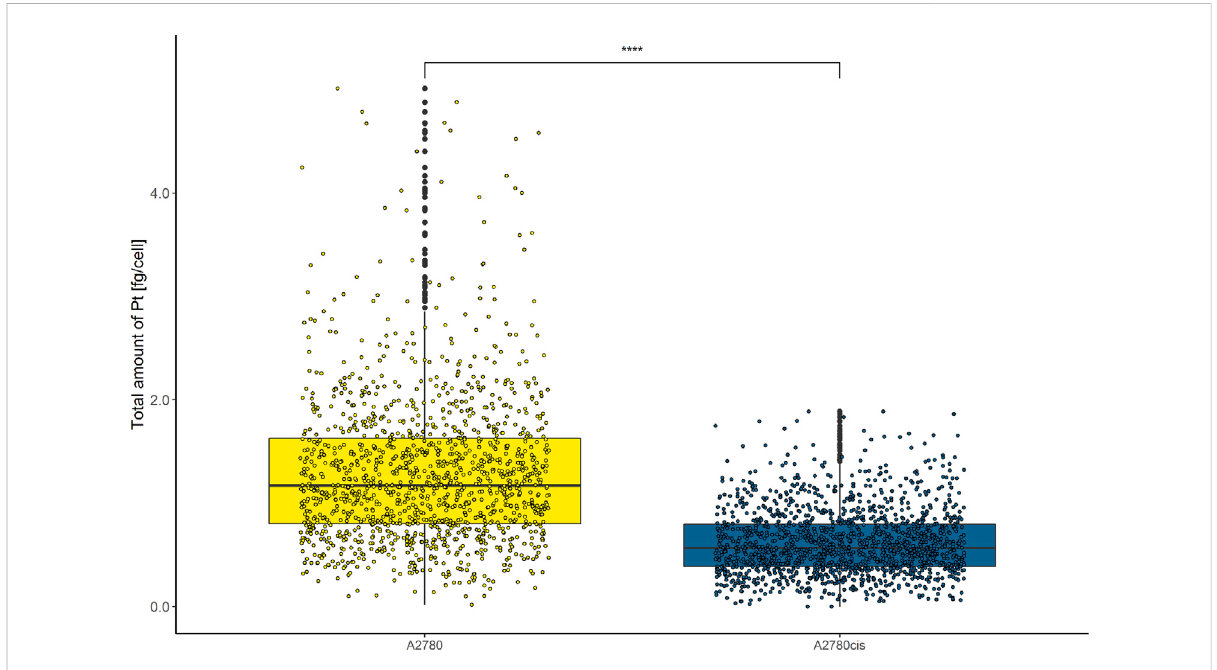
FIGURE 1 Box plots showing the concentration of Pt cell − 1 of A2780 and A2780cis cells treated with 10 µM cisplatin for 6 h. Cytospin samples were measured by LA-ICP-TOFMS at the single-cell level. The results are based on ~1,500 cells for each cell type. A Wilcoxon test was performed for